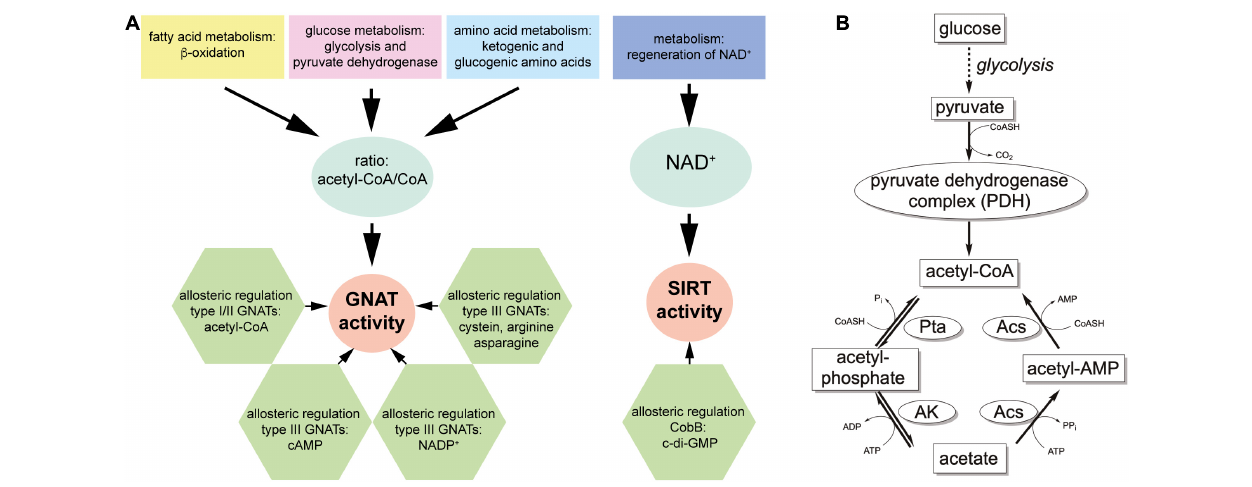
FIGURE 5 | Ac(et)ylation is a modification of molecules that is tightly connected to the cellular metabolic state. (A) Left panel: GNATs depend on ac(et)yl-CoA as donor molecule for the transfer of the ac(et)yl group to the substrate amino group. Shown is only acetyl-CoA but dependent on the specificity of the GNATs for different acyl-CoAs, also other acyl groups can be transferred. Acetyl-CoA is generated in the metabolism of all major nutrient classes. Dependent on the metabolic state, the intracellular concentration of ac(et)yl-CoA fluctuates. The catalytic efficiency of the GNATs depend on the intracellular acetyl-CoA/CoA ratio rather than the acetyl-CoA concentration. This is reflected by the similar K M -values of GNATs for ac(et)yl-CoA and CoA. Moreover, several GNATs are regulated by binding of metabolic molecules such as cAMP, NADP + , acetyl-CoA and amino acids to accessory, allosteric sites. Binding of the ligands to the allosteric site modulates GNAT activity constituting another layer for regulation of GNAT activity. Further regulatory systems include post-translational modifications of GNATs, not shown here. Right panel: sirtuin activity is also tightly connected to the cellular metabolic state. Sirtuins use NAD + as stoichiometric co-substrate for catalysis and other endogenous regulators such as c-di-GMP for CobB also exist. As described for GNATs, also sirtuins are regulated by post-translational modifications which are not shown here. (B) Acetyl-phosphate is the major factor for non-enzymatic acetylation in bacteria. Acetyl-CoA is formed during metabolism of all major nutrient classes. Shown is the formation of acetyl-CoA through glycolysis starting from glucose to form pyruvate, which is oxidatively decarboxylated to form acetyl-CoA by the pyruvate dehydrogenase complex (PDH). Acetyl-CoA can subsequently further metabolized either by oxidative phosphorylation under aerobic conditions to drive formation of ATP and regeneration of NAD + or it is converted to acetate by phosphotransacetylase (Pta) catalyzing the formation of acetyl-phosphate and acetate kinase (AK) yielding acetate. Both reactions are reversible, i.e., AK and Pta can also convert acetate to acetyl-CoA under consumption of ATP. Alternatively, the acetate can be converted by acetyl-CoA synthetase (Acs) to form acetyl-CoA. Due to the production of pyrophosphate (PP i ) in the first half reaction yielding acetyl-adenylate (acetyl-AMP), this reaction is almost irreversible. Under conditions of carbon overflow, the intracellular acetate concentration ( > 5 mM) increases so that also the reaction catalyzed by AK and Pta to produce acetyl-CoA from acetate becomes important. This results in accumulation of acetyl-phosphate under conditions of carbon overflow causing systemic non-enzymatic